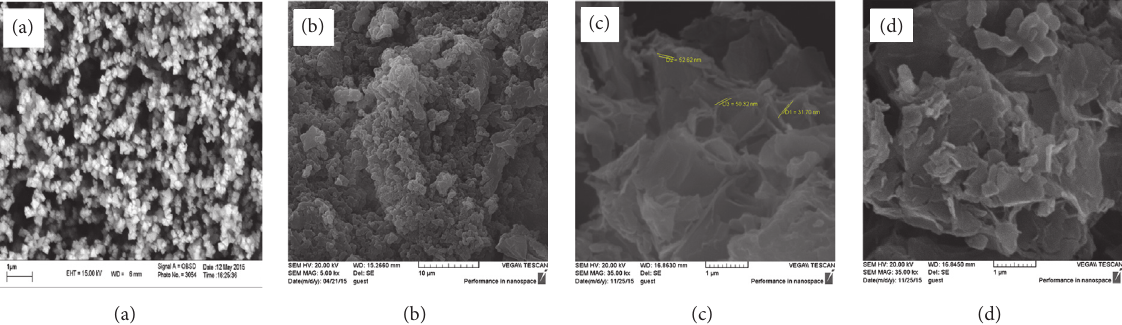
Figure 1: The SEM micrographs of Fe 3 O 4 nanoparticles (a), PGMA-MAn copolymer (b), and PGMA-MAn/ABSAc@Fe 3 O 4 nanocomposite before (c) and after (d) complexation with Cu(II) ions.